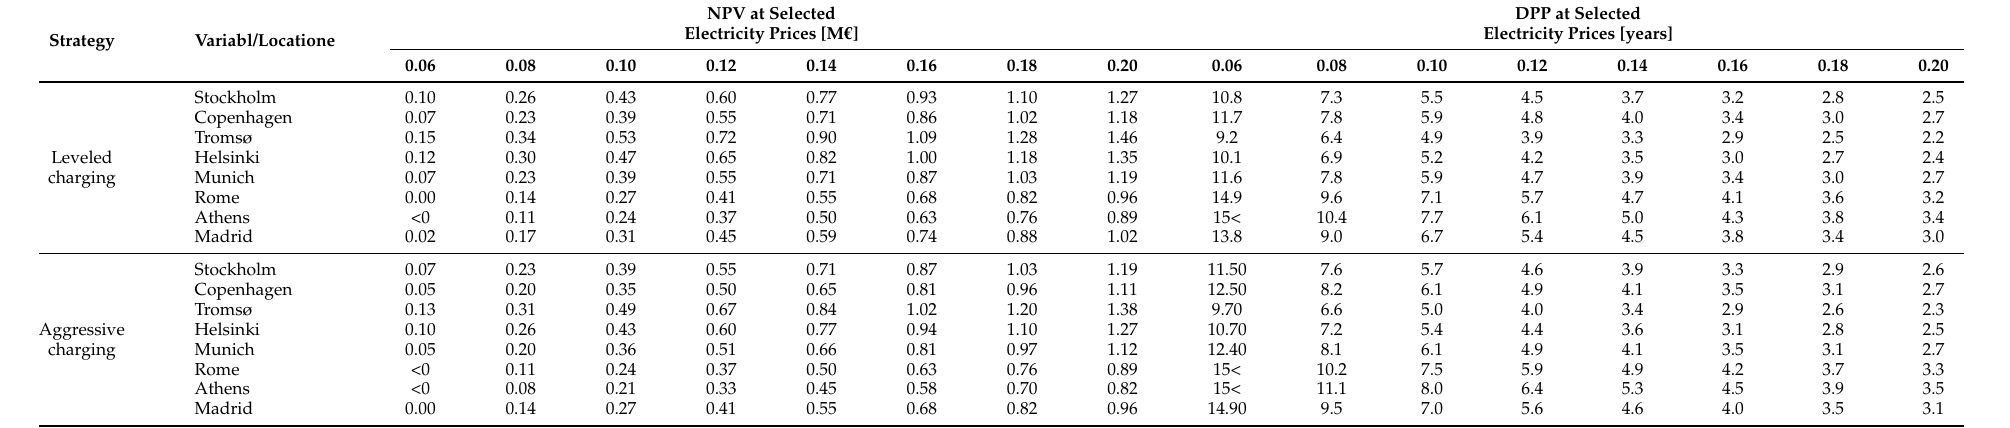
Table A2. Net present value (NPV) and discounted payback period (DPP) for selected cities with the EJ design at different electricity prices when applying the leveled and aggressive charging strategy.